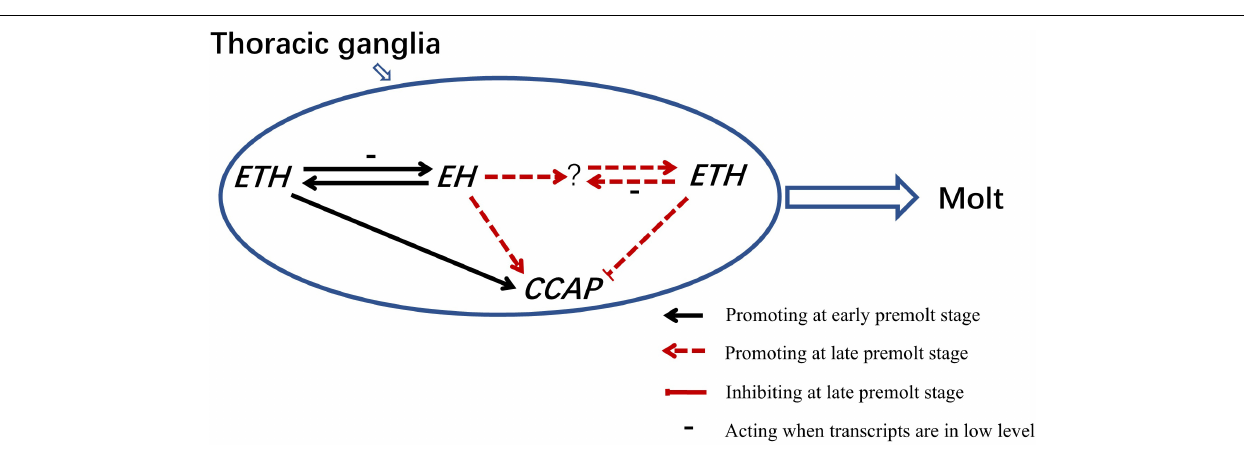
FIGURE 7 | A model of ETH , EH , and CCAP genes in the regulation of molting behavior in Scylla paramamosain